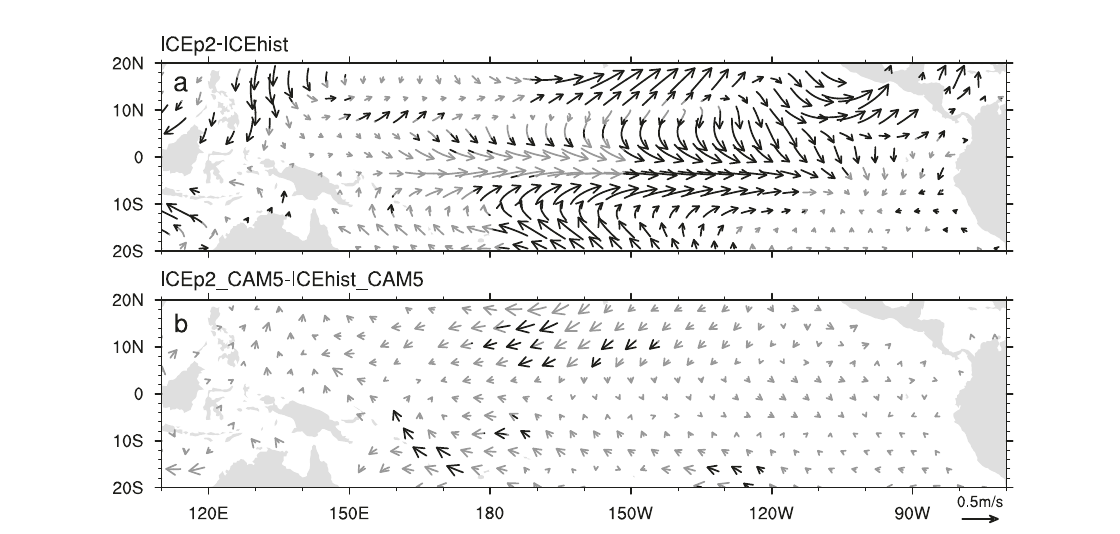
Fig. 3 | Responses of seasonal sea-level pressure to the seasonally ice-free Arctic. a – d Difference between the time-slice-coupled model experiment with fi xedArcticseaiceduring2080 – 2099(ICEp2)andduring1980 – 1999(ICEhist),and e – h difference between the atmosphere-only model experiment with fi xed Arctic